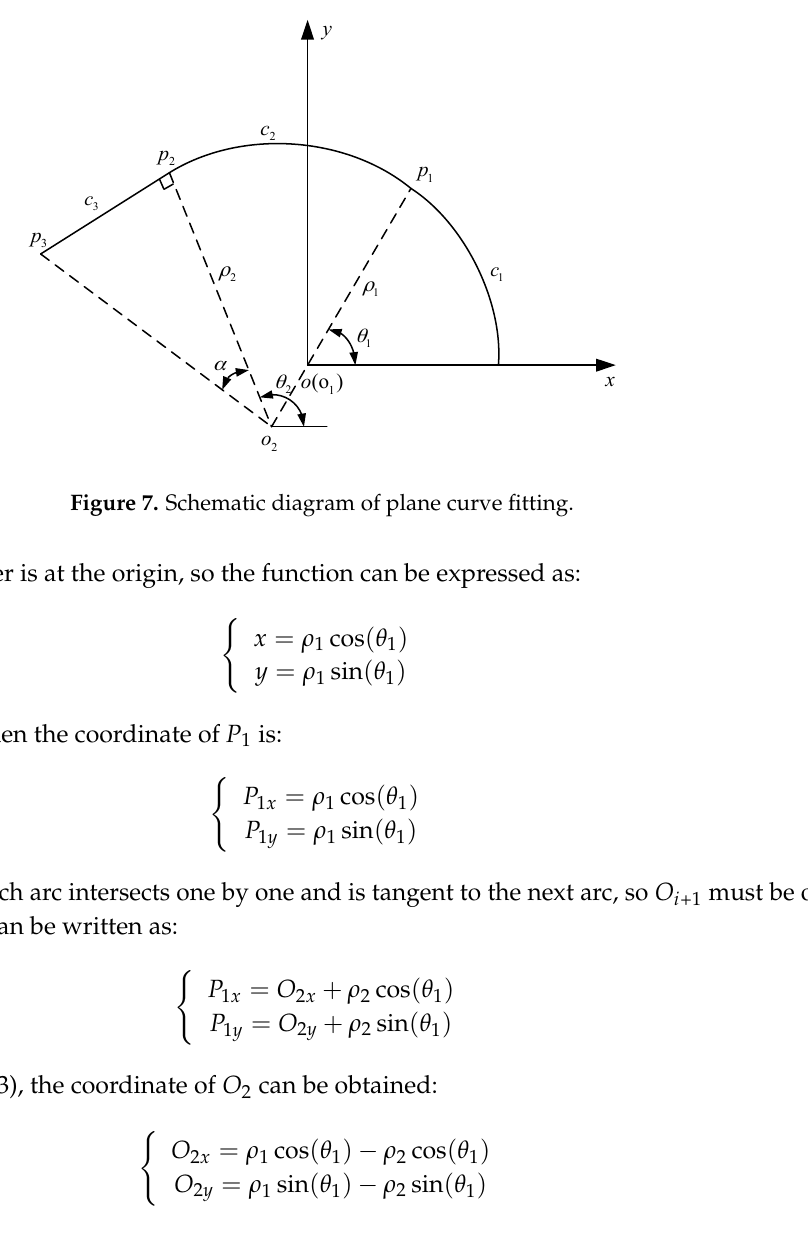
Figure 6. Measurement of Young’s modulus of the tissue.